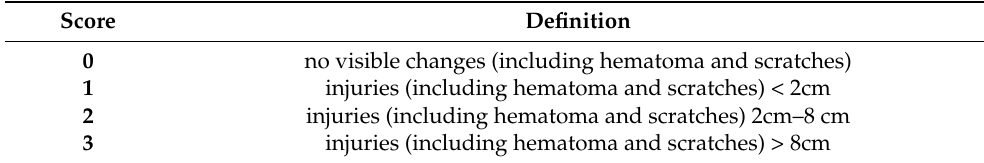
Table A4. Scoring system of the injuries on the body